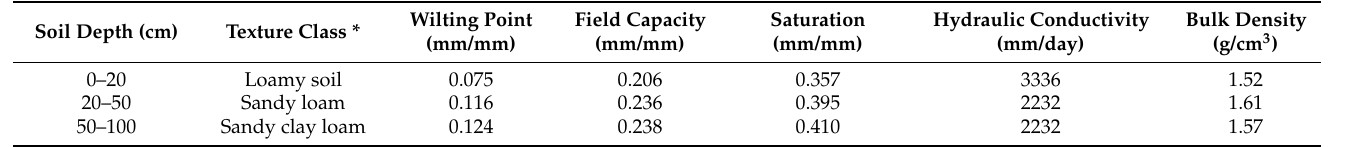
Figure 1. Monthly weather data for Khon Kaen (KK) during 2010/12–2012/12; Rain: mean monthly rainfall (mm); Radn: daily solar radiation (MJ/m 2 ); Maxt: daily maximum temperature ( ° C); Mint: daily minimum temperature ( ° C). Table 2. Properties of soil in the experimental field in KK.